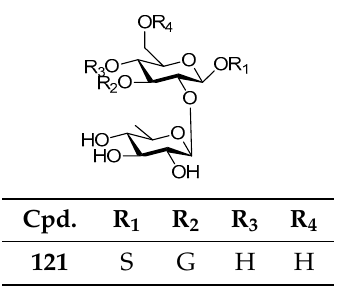
Figure 7. Structure of compound 121 .